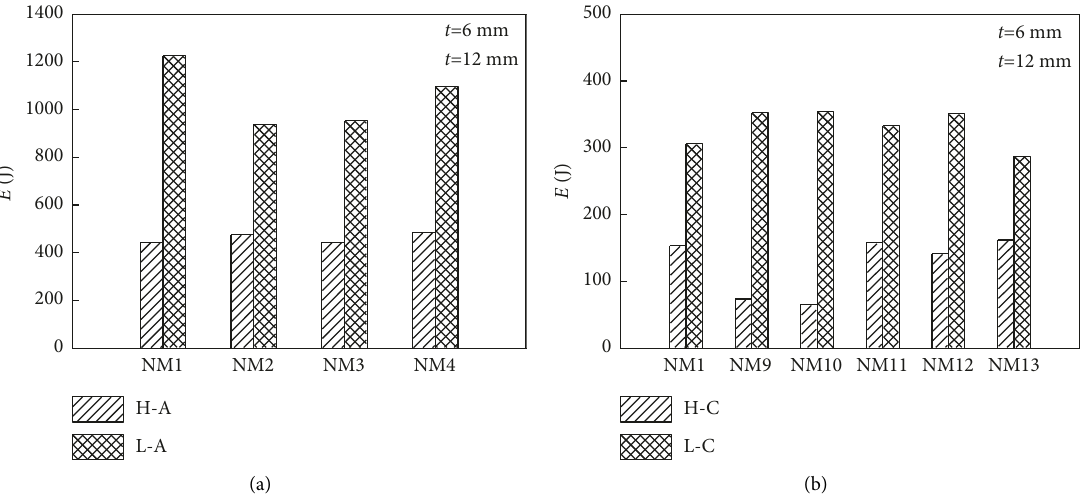
Figure 8: Hysteresis energy of specimens with different welding steel. (a) Hysteresis energy of specimens with label A. (b) Hysteresis energy of specimens with label C.